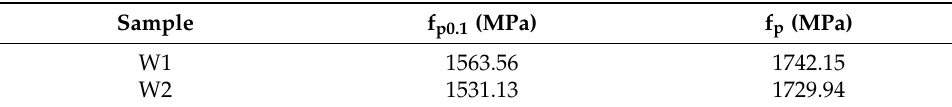
Figure 5. Sampling procedure of steel. Exposed prestressing wires ( a ); samples ( b ). Table 2. Materials properties of prestressing steel.